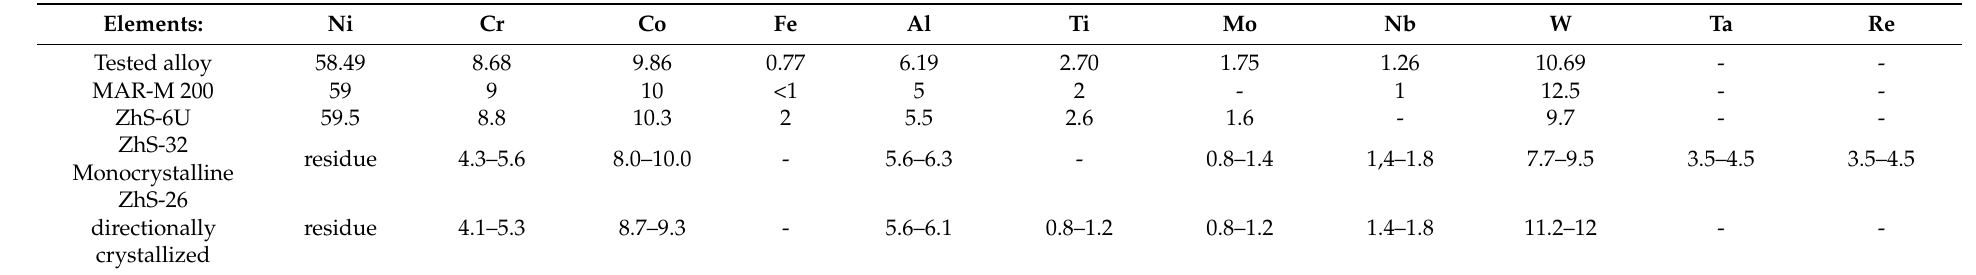
Table 2. Weight percentage (%) of individual alloy